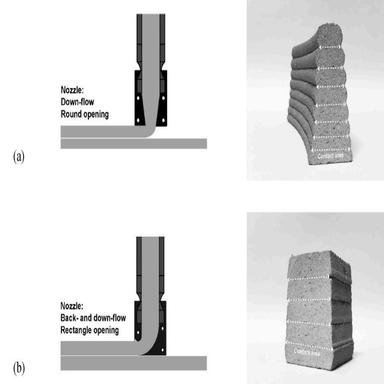
(a) Illustration of the printing using the down-flow nozzle with a round opening and the cross-section of the printed sample. (b) Illustration of the printing using the back- and down-flow nozzle with a rectangle opening and the cross-section of the printed sample. The dashed line represents the contact area between layers. Modified from Ref..